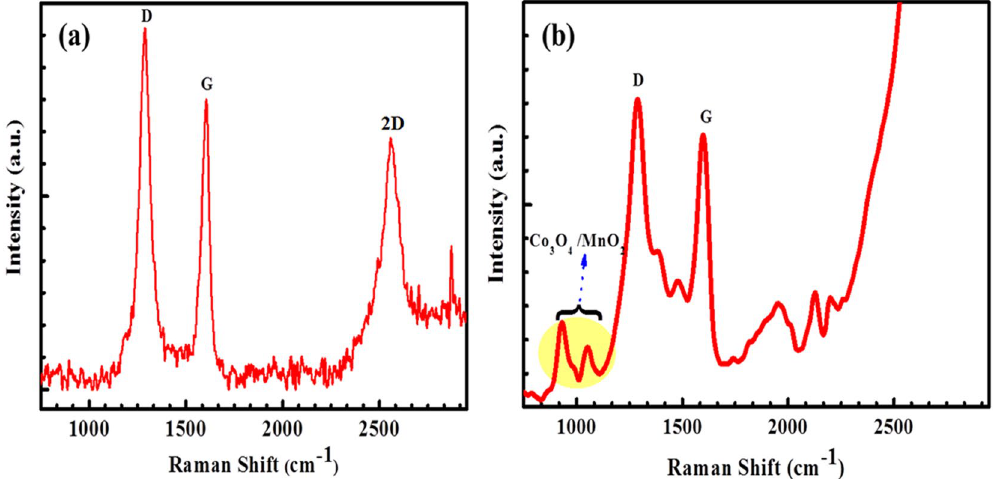
Figure 1. FT-Raman analysis of ( a ) NGO and ( b ) Co 3 O 4 @MnO 2 /NGO composite